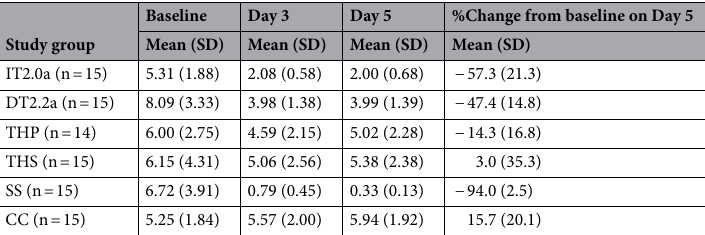
Table 5. Nicotine uptake in each study group (nicotine equivalents, µg/mg creatinine). CC combustible cigarettes group, DT2.2a direct tobacco heating system platform 2 generation 2 version a group, IT2.0a